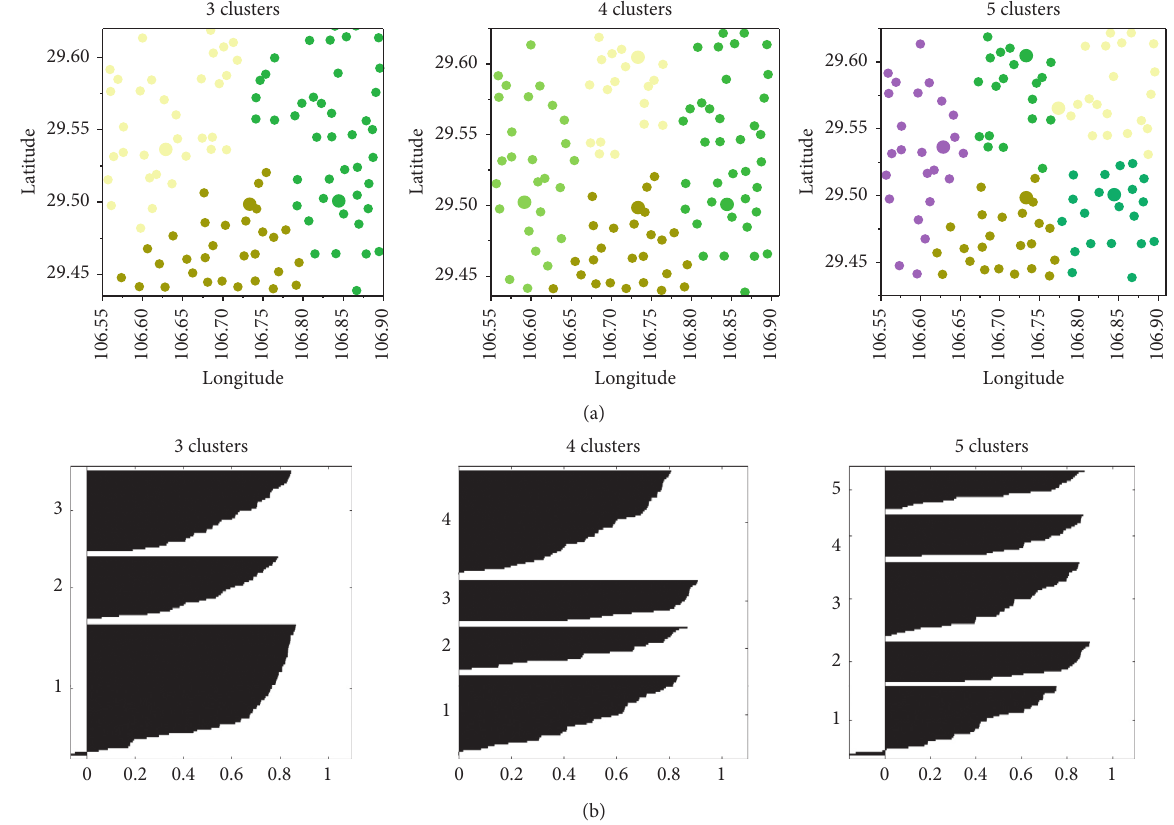
Figure 6: Customer (a) clustering results and (b) silhouette